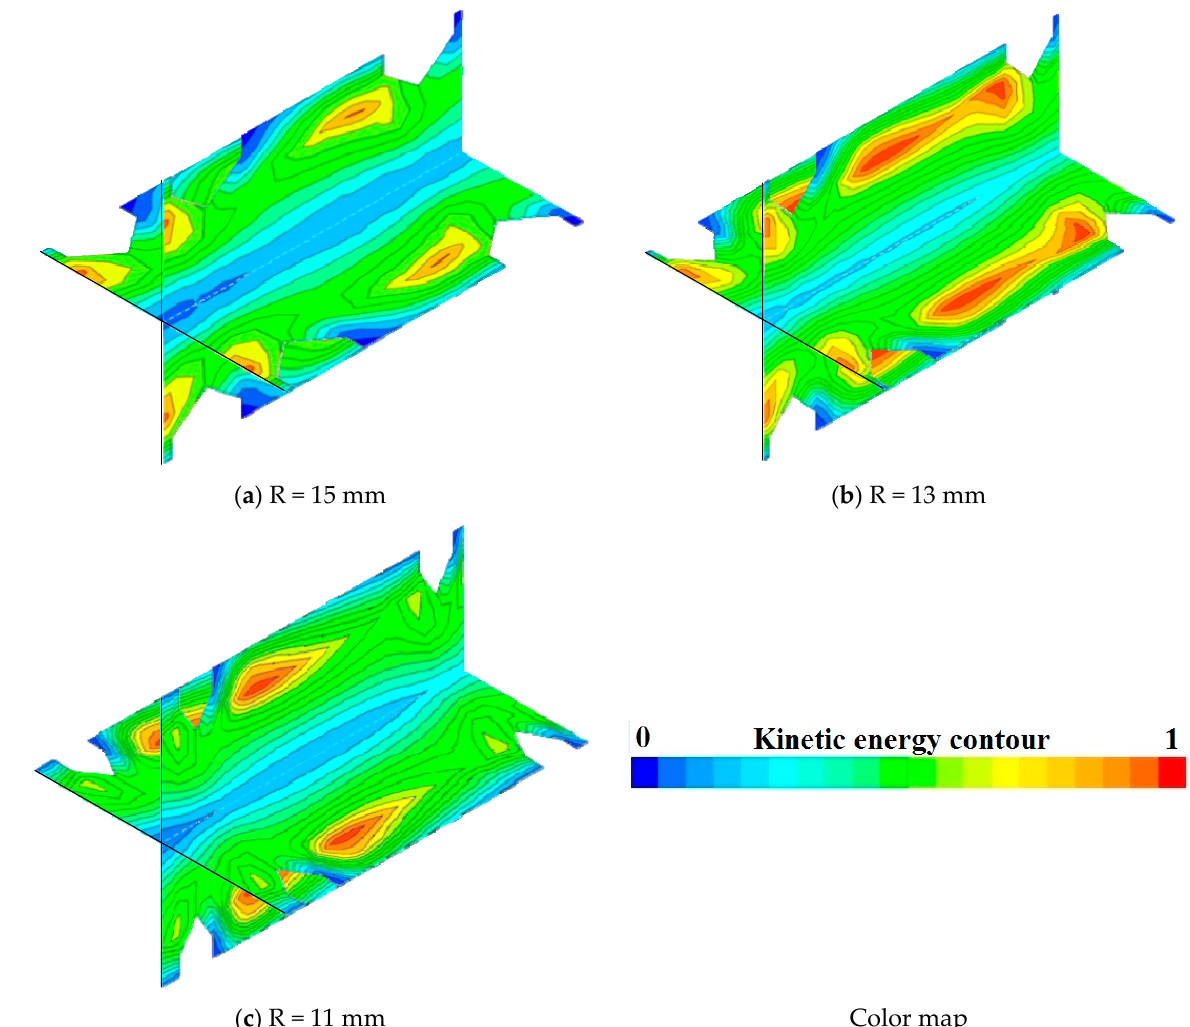
Figure 14. Kinetic energy contours for various configurations of Case B with different R parameters at B 2 = 24 mm, Re = 15,000, and 𝜑 = 0.5%.